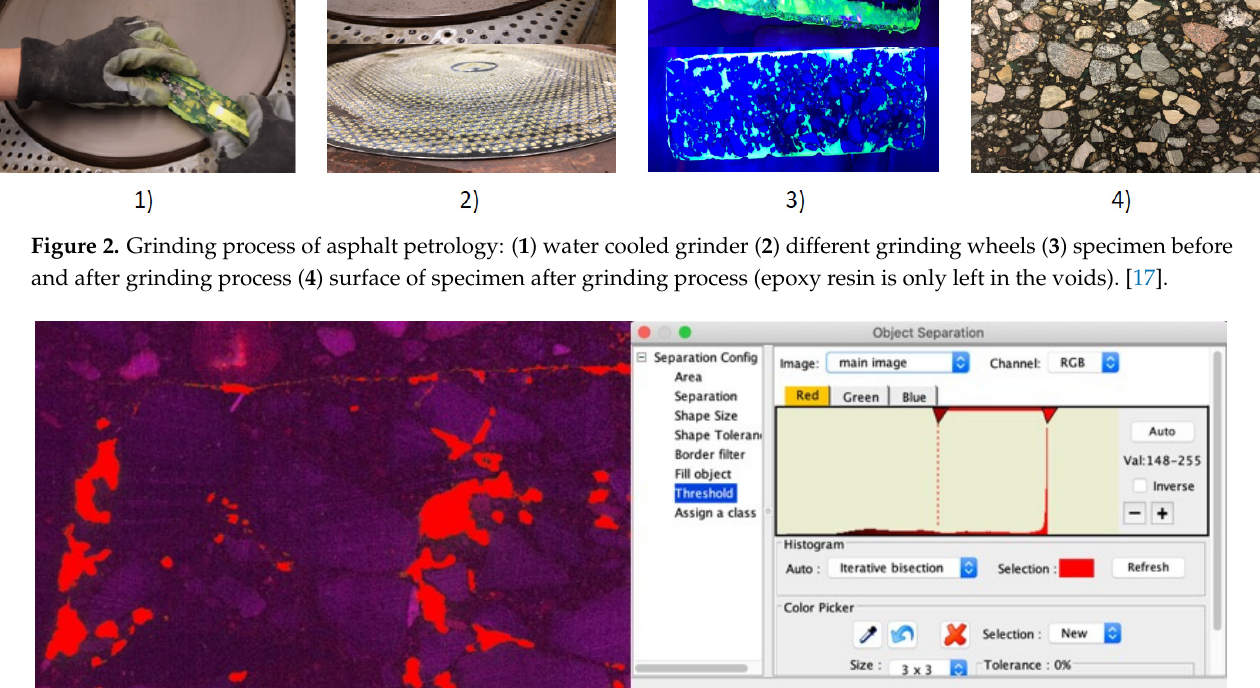
Figure 2. Grinding process of asphalt petrology: ( 1 ) water cooled grinder ( 2 ) different grinding wheels ( 3 ) specimen before and after grinding process ( 4 ) surface of specimen after grinding process (epoxy resin is only left in the voids). [17].